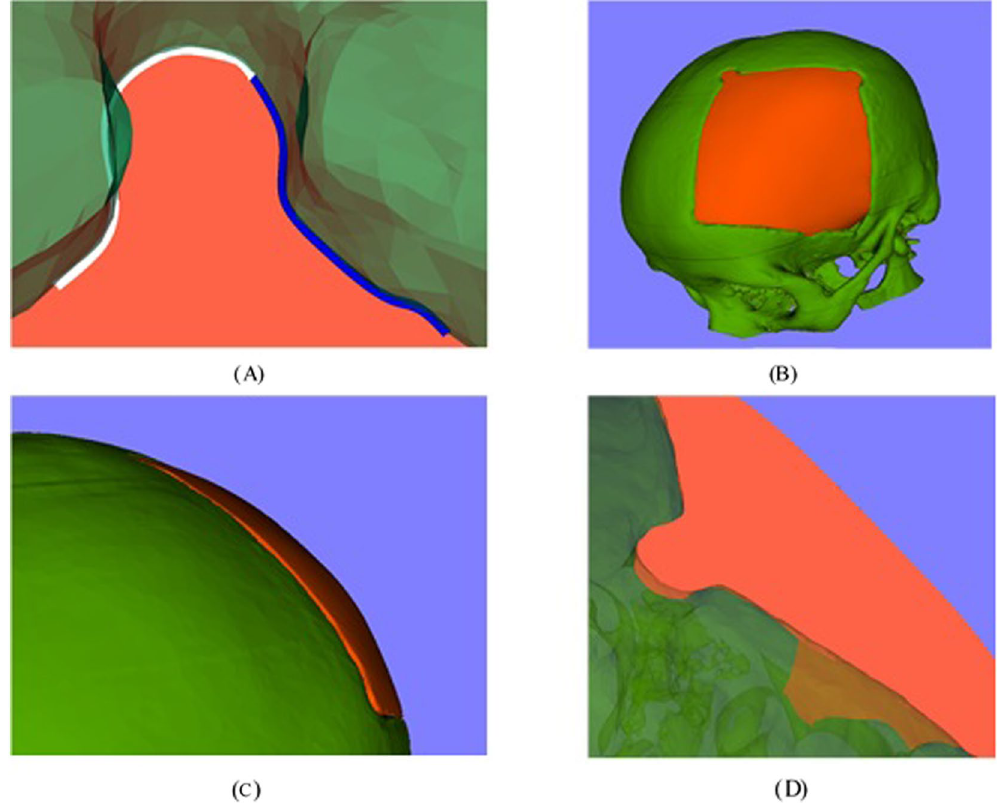
Figure 12. The final implant: ( A ) the contour along the edge of the defect from inner surface of the crania model, ( B ) the final implant and the crania model, ( C ) and ( D ) different view of the final